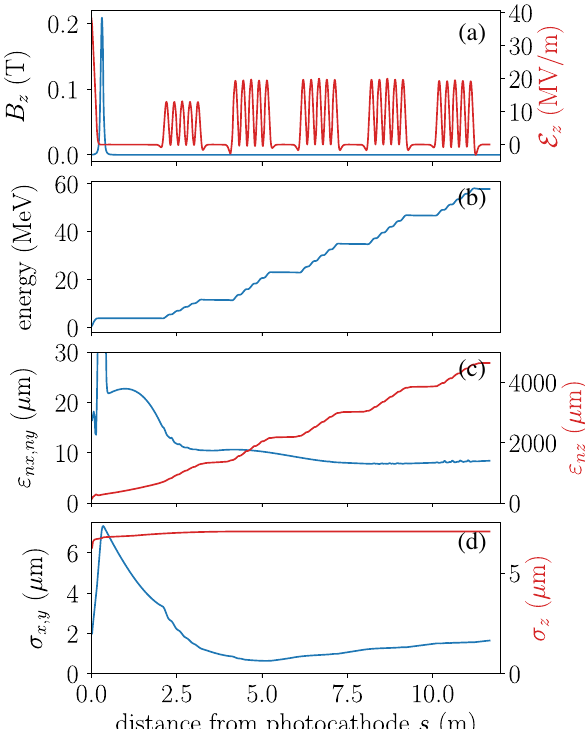
FIG. 7. Axial electric E (red trace) and magnetic B (blue z z trace) fields experienced by the reference particle as it propagates along the optimized photoinjector (a) with corresponding kinetic energy (b), transverse (blue) and longitudinal (red) beam emit- tances (c), and sizes (d) evolving along the injector.